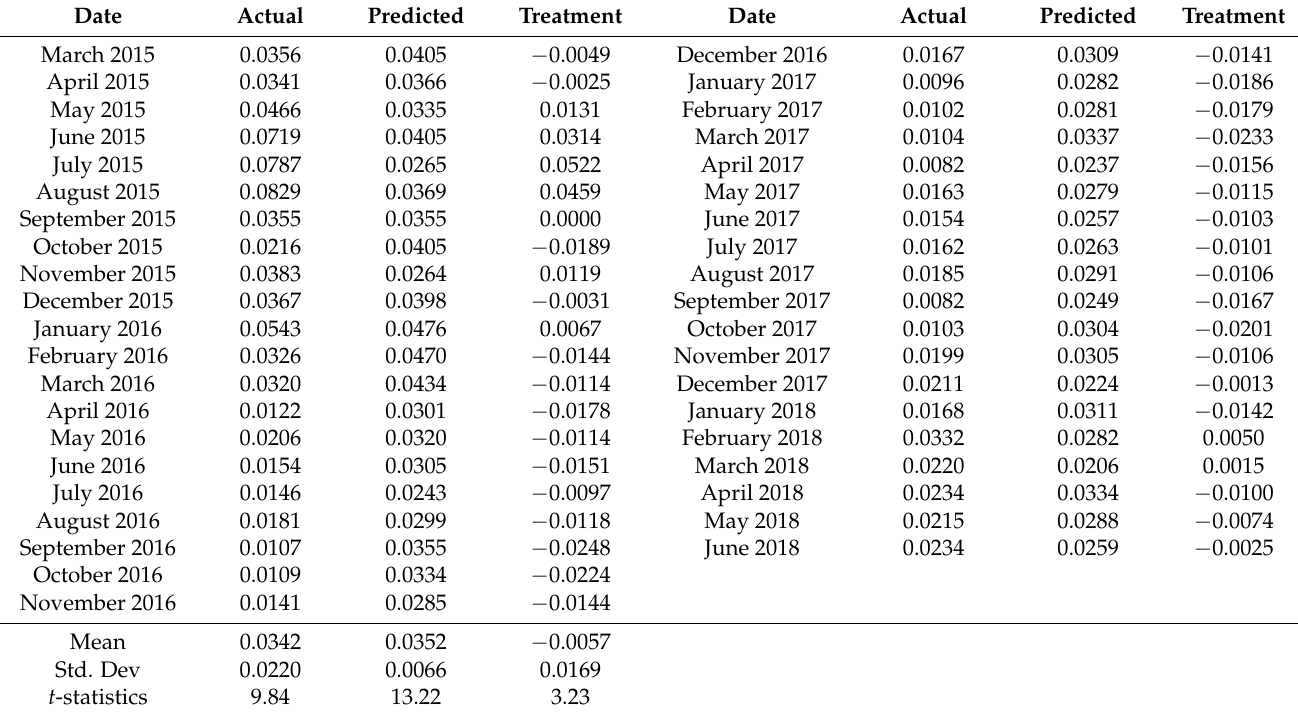
Table 2. Monthly treatment effect based on panel data evaluation